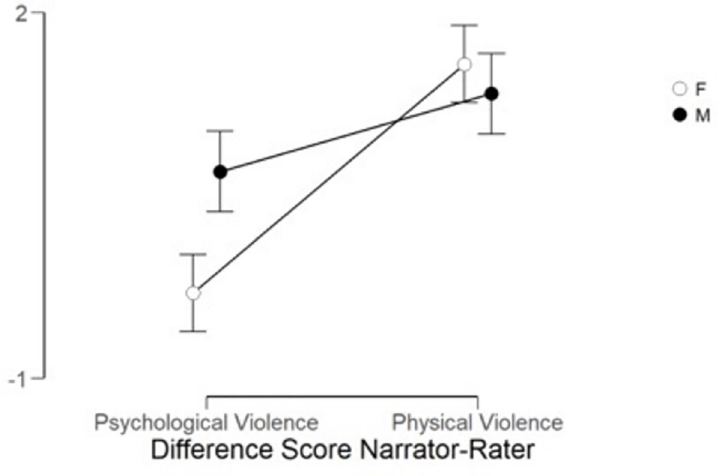
Fig 5. Difference score between severity ratings of violence for narrator and rater in Phase 3 using gender- reversed narrator stories. F (hollow circle) stands for female and M (filled circle) for male gender, psychological violence is on the left side and physical on the right side. Bars show 95% confidence